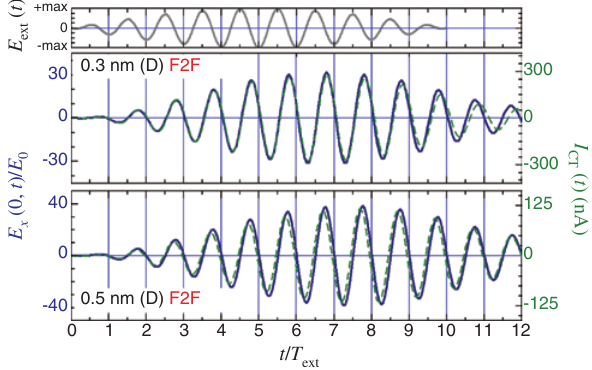
Figure 11: Time evolution of induced currents (dashed green lines) and total electric fields (solid blue lines) at the middle of the dimer junction ( r = 0) due to the resonant coupling of selected modes of the F2F nanoparticle dimer with an applied external monochromatic field (depicted in the upper panel) of frequency ω and maximum ext = 10 -6 a.u. The subsequent free evolution during a time amplitude E 0 interval Δ T = 4 π / ω after the disappearance of the external field is ext also